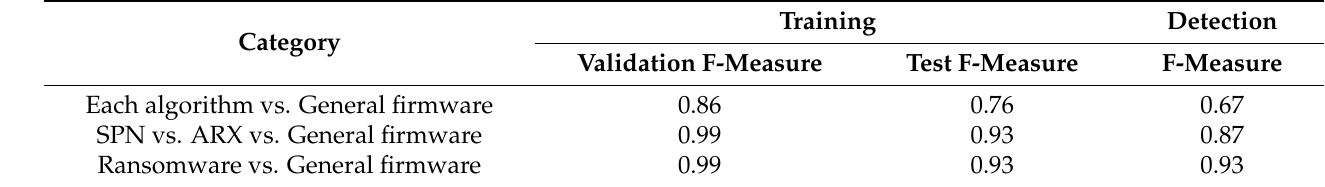
Table 7. Evaluation of sequence-only model.